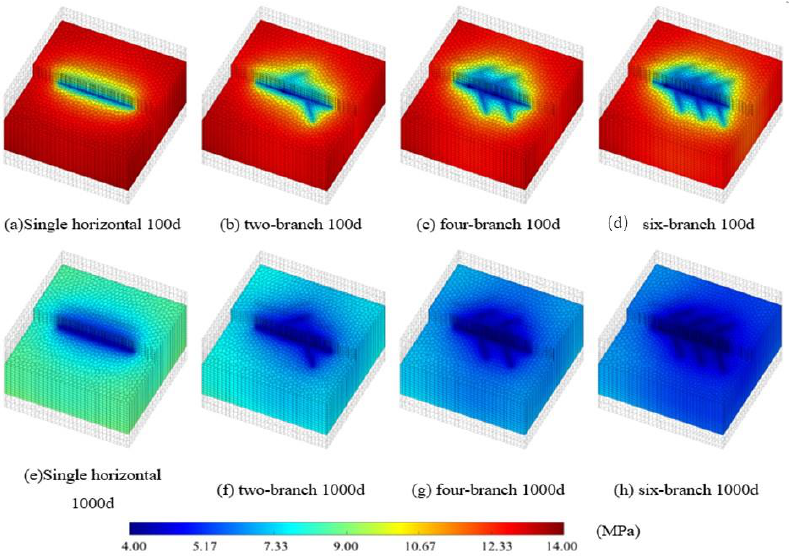
Figure 6. Pressure field in depressurized development of fishbone well with different number of branches.